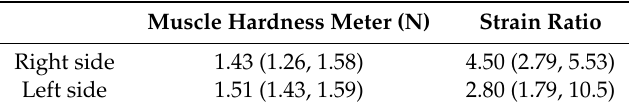
Table 3. Data on upper trapezius hardness value (n = 20).